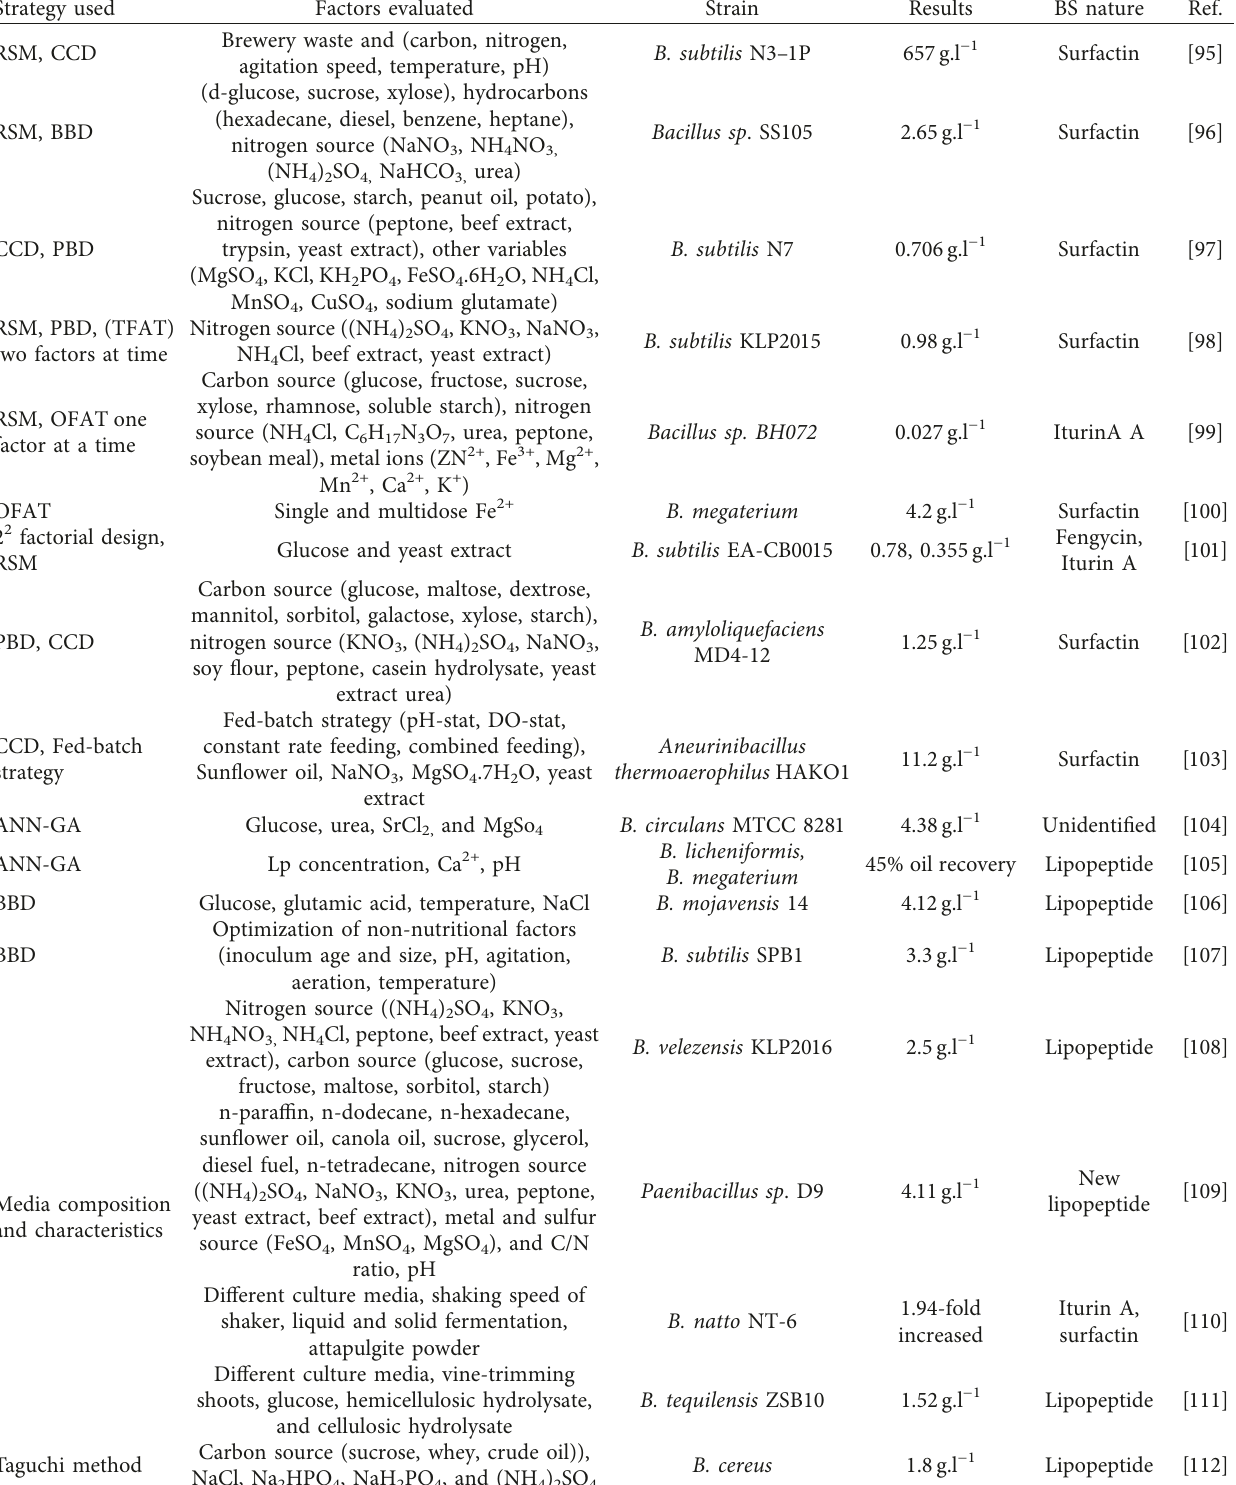
Table 2: Strategies and mechanisms used to enhance lipopeptide production by Bacillus sp